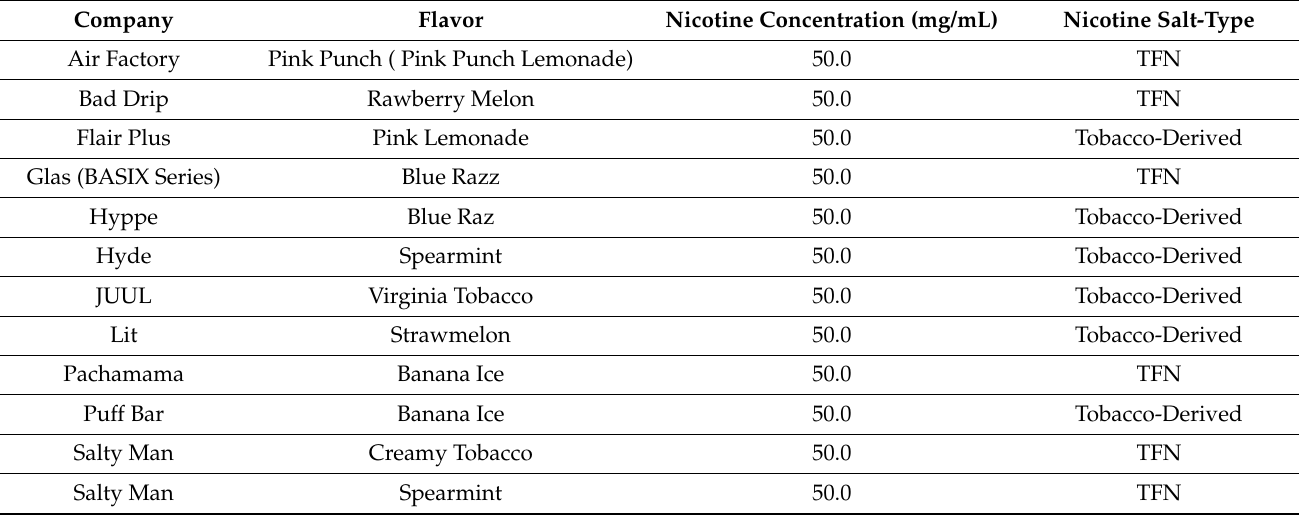
Table 1. Tobacco-derived and tobacco-free nicotine ENDS used in this